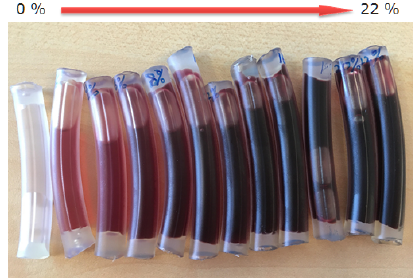
Figure 9. Test specimen samples. Tube segments were filled with diluted blood and sealed with hot glue. In order to test the effect of bubbles, a small fraction of air was left inside. This also prevented direct contact between the hot glue and test liquid. Samples were produced for blood concentration between 0% and 22% in increments of 2%. Hb concentration was measured using a hemoglobin